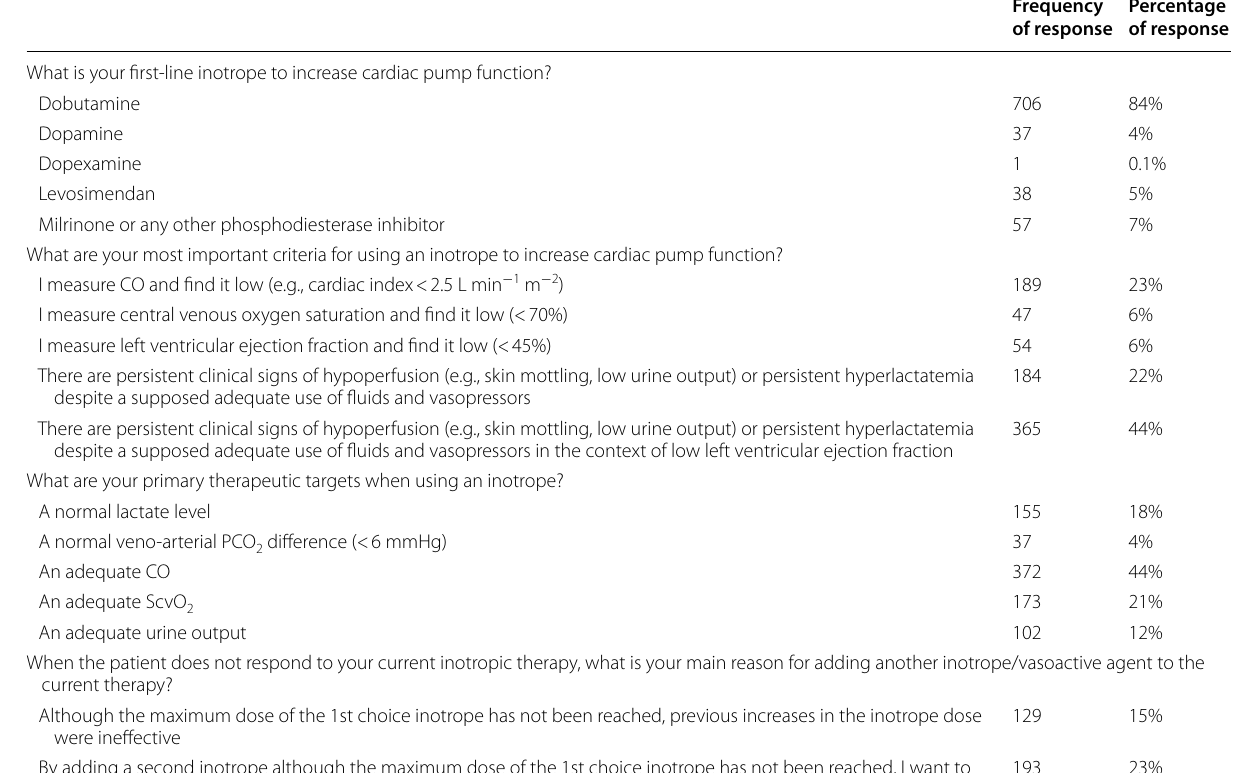
Table 1 Survey questions on inotropic use